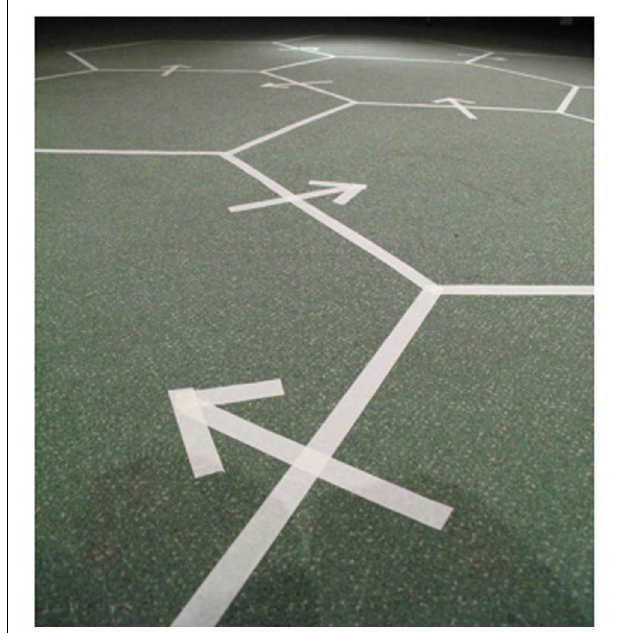
FIGURE 1 | Photograph of the dance floor showing the taped hexagons. The hexagons were connected by a series of arrows outlining a path to be followed by the